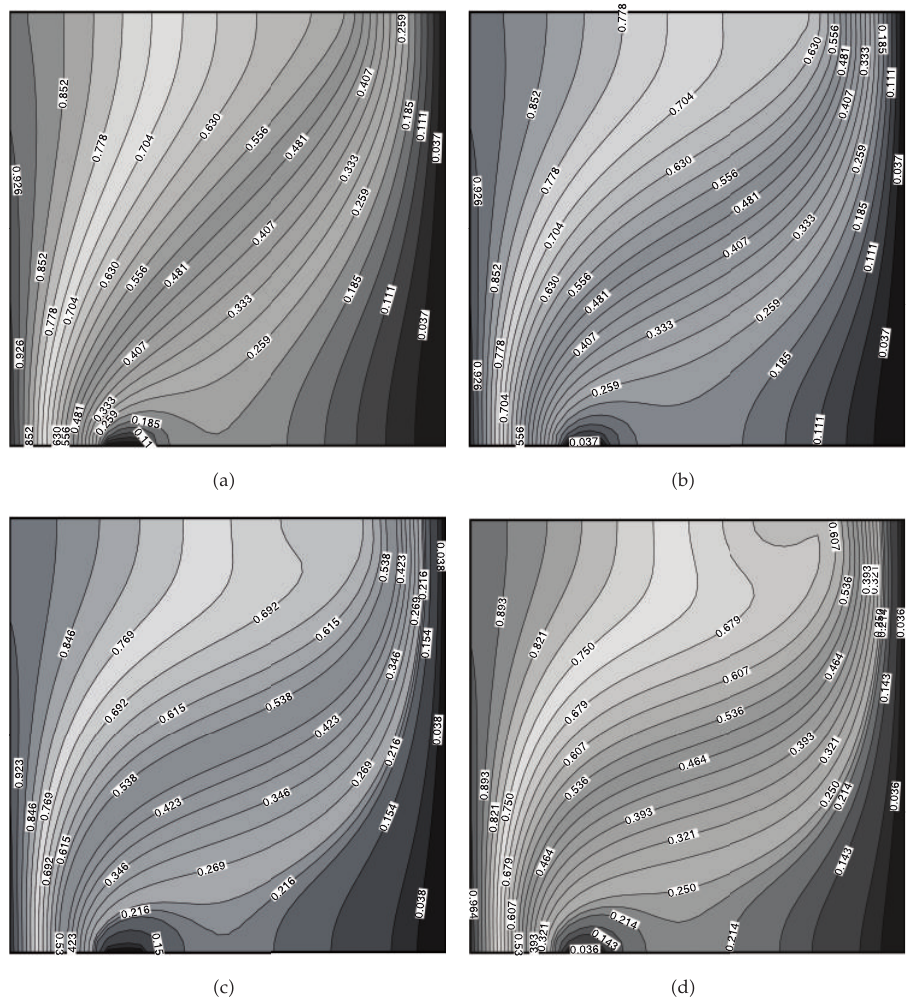
Figure 18: Isoconcentration contours along the left vertical wall while fixing B (cid:8) 1, D/H (cid:8) 0 . 1, a (cid:8) 0 . 1, Ra (cid:8) 100, S C (cid:8) 0 . 1 for (cid:2) a (cid:3) Le (cid:8) 0 . 25, (cid:2) b (cid:3) Le (cid:8) 0 . 5, (cid:2) c (cid:3) Le (cid:8) 0 . 75, (cid:2) d (cid:3) Le (cid:8) 1 .